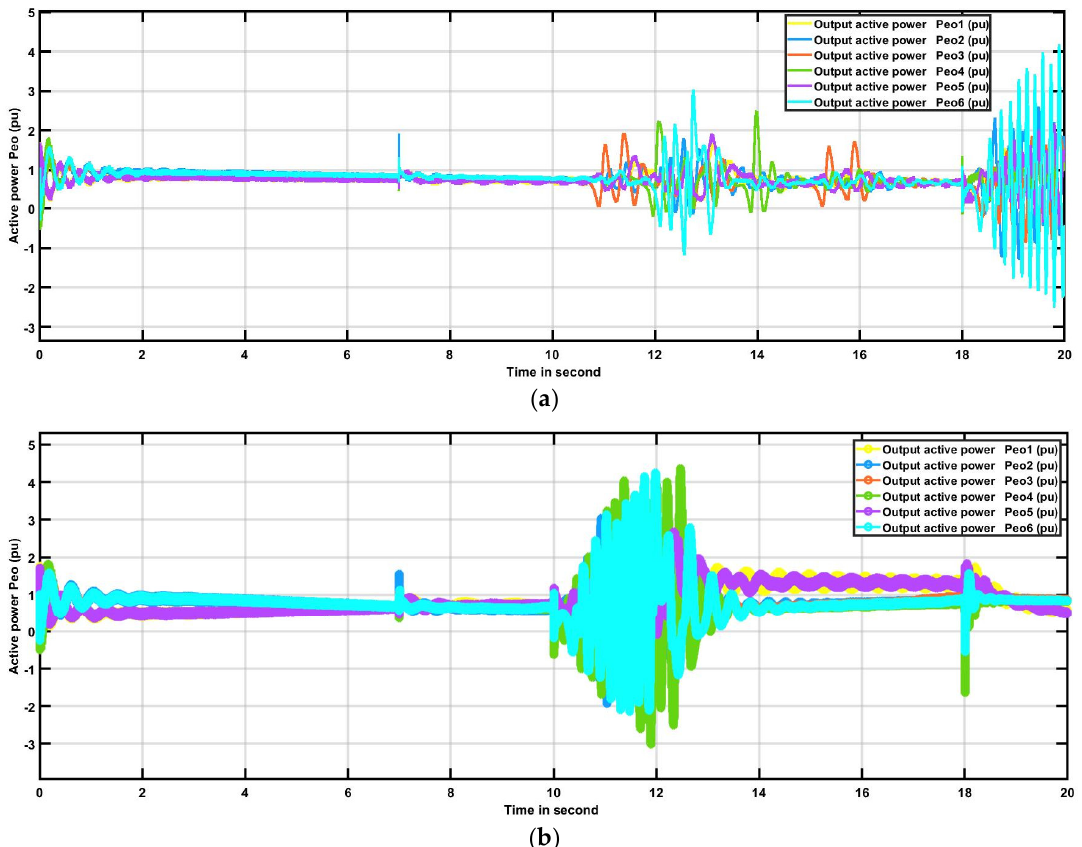
Figure 13. System responses to fault scenario with constant time delays of 900 ms ( a ) and 100 ms ( b ).